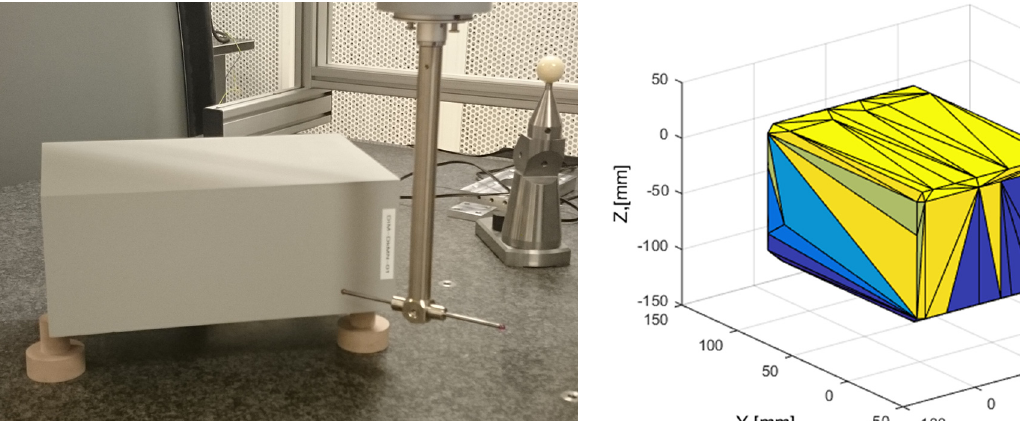
Fig. 11. CMM measurement of the test object.